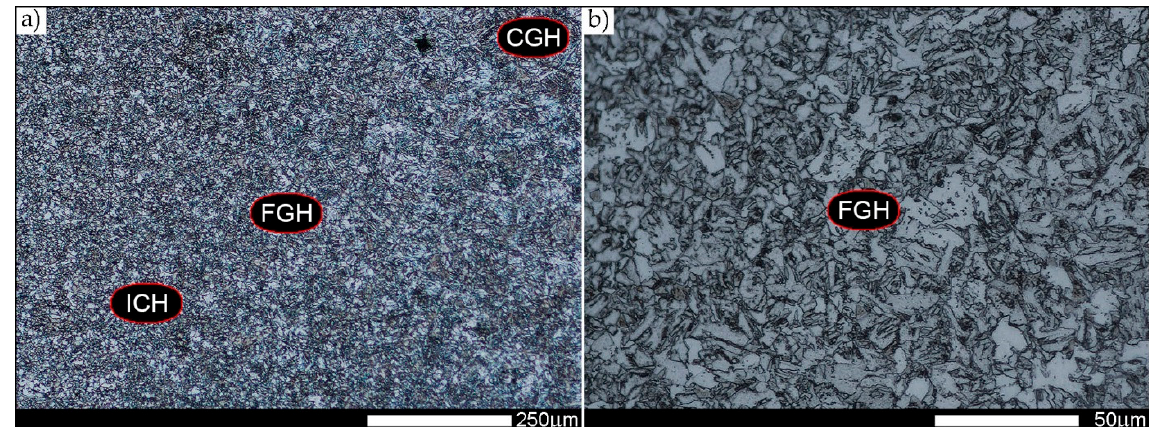
Figure 11. Microstructure of welded joint of Hardox 450 steel in the delivery state (directly after welding)—FGHAZ zone shown in Figure 2a. ( a ) 100 × ; ( b ) 500 × . Fine-grained, morphologically diversified structure consisting of quenching martensite, quenching sorbite and single (small size) colonies of quenching troostite. CGH(AZ)—coarse-grained zone, FGH(AZ)—fine-grained zone, ICH(AZ)—intercritical zone. Light microscopy, etched with 3% HNO 3 .